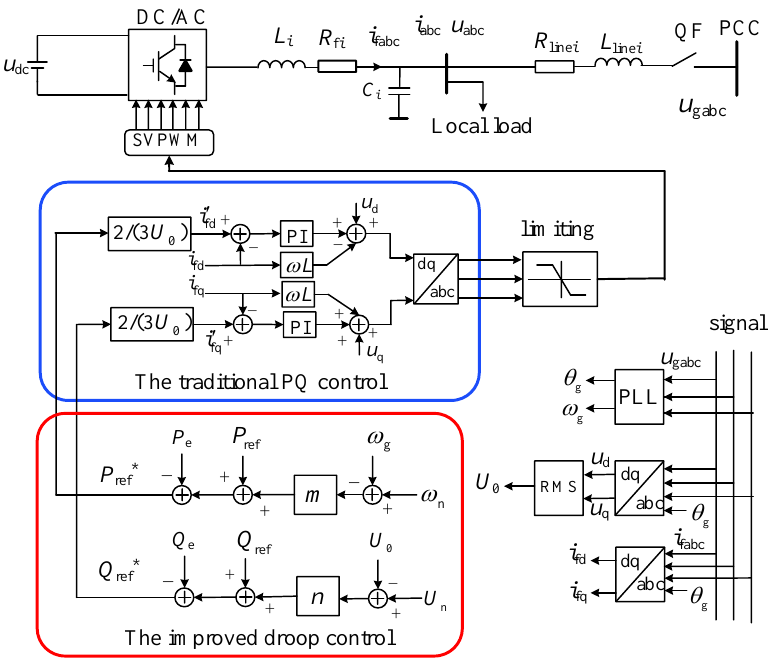
Figure 3. Control structure block diagram of improved droop control.